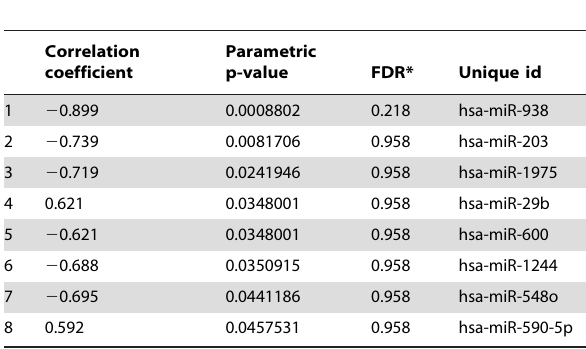
Table 1. MicroRNA expression changes with exposure to HAG (260 m g/ml): Trend Change Analysis.